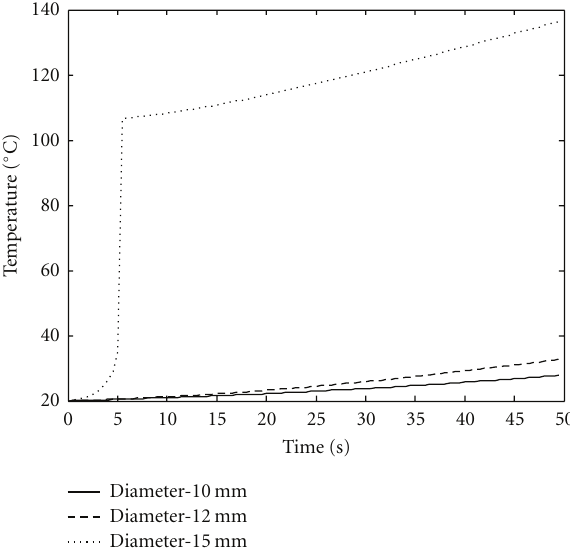
Figure 11: Temperature response, at constant microwave power density, in the centre of a plant stem as a function of plant stem diameter, calculated using (4) and assuming constant moisture loss from a moisture content of 0.87 to 0.10 during microwave